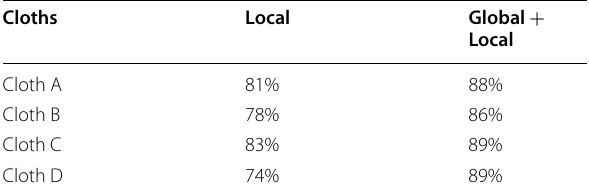
The middle column shows the percentage of correctly classified pixels using only the local classifier and the right column shows the result after the refinement with the global